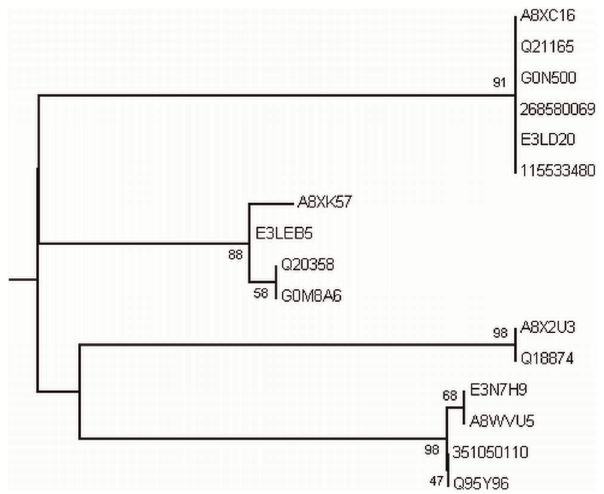
Figure 10. Group VI. Tree showing all proteins included in this group.